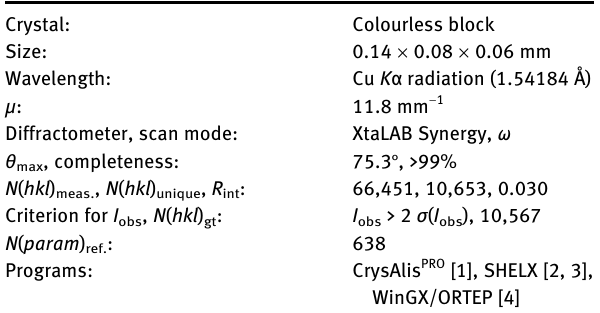
The molecular structures are shown in the Figure. Table 1 contains crystallographic data and Table 2 contains the list of the atoms including atomic coordinates and displace- ment parameters. Table  : Data collection and